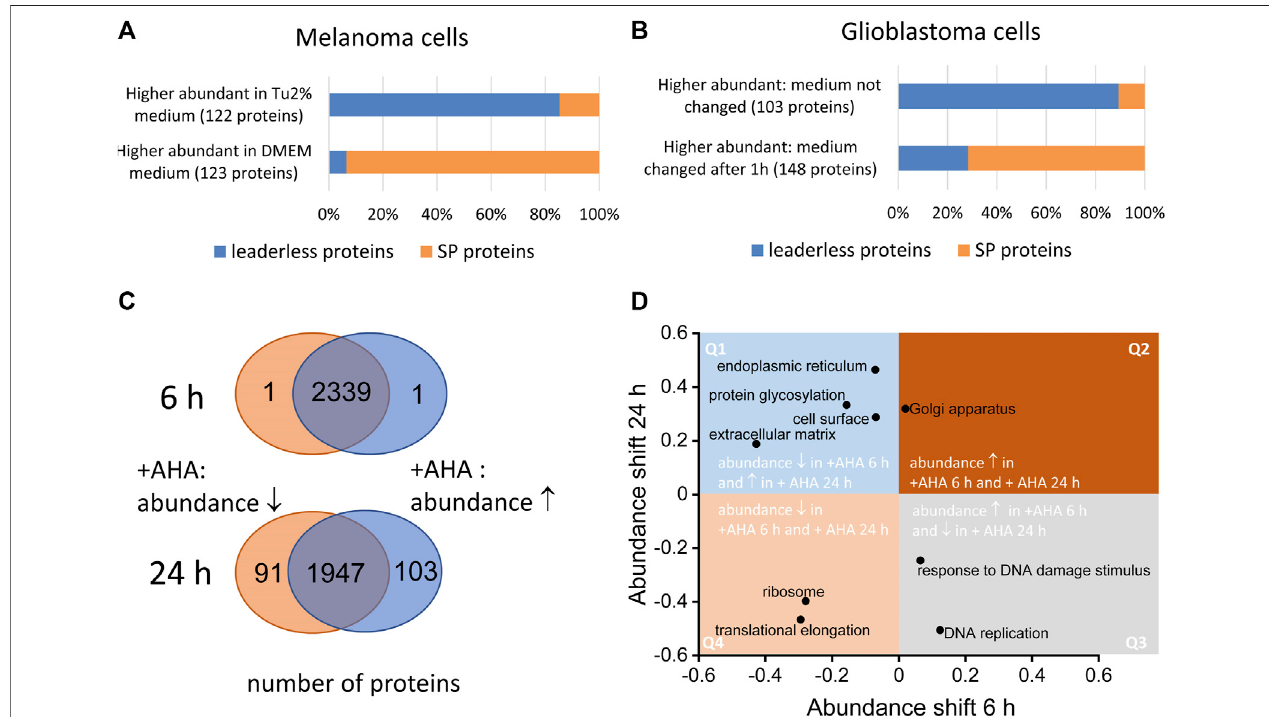
FIGURE2 | Effectofcell culture conditions on the secretome.Both serum-free and serumcontainingapproached might in fl uence thecomposition ofsecretomes. (A) WM3918 melanoma cells (n = 3 dishes per group) were cultivated for 24 in serum free medium. Cells expanded in DMEM showed a signi fi cantly higher proportion ( p -value 2.2E-16, Fisher ’ s exact test) of signal-peptide containing proteins (SP proteins) at higher abundances in secretomes, whereas in Tu2% medium based secreteomes, putative LLSP showed higher abundances in comparison to expansion in DMEM. (B) LN18 glioblastoma cells (n = 3 per group) were incubated for 24 h in serum-free medium. After 1 h, the medium was replaced in one set of samples. In this samples, signal peptide containing proteins showed higher intensities in resulting secretome samples whereas in samples in which the medium was not changed after 1 h, a signi fi cant higher proportion of putative LLSP could be found at higher intensities ( p -value 2.2E-16, Fisher ’ s exact test). (C) Normal human dermal foreskin fi broblasts were cultured with azidohomoalanine (AHA) or methionine as control for 6 and 24 h (n = 5 dishes per group). After MS analysis, different abundant proteins were determined by the Student ’ s t -test based signi fi cance analysis of microarrays approach (Tusher et al., 2001). Whereas after 6 h only 2 proteins (of 2441 cellular proteins) showed a signi fi cant AHA induced abundance change, 194 proteins (of 2141 cellular proteins) showed an abundance change after 24 h (D) . This dataset was also used for the analysis of global shifts in abundance on the level of proteins grouped by gene ontology annotations (Cox and Mann, 2012). Selected GOCC and GOBP categories are shown indicating the size of the abundance shift of associatedproteins.Whereasproteinsforsomecategoriesshowanabundancechangeinthesamedirectionafter6and24 hAHAincubation(foundinquadrantQ2and Q4), other protein groups show an AHA induced abundance shift in the opposite direction at the two timepoints (found in quadrant Q1 and Q3).